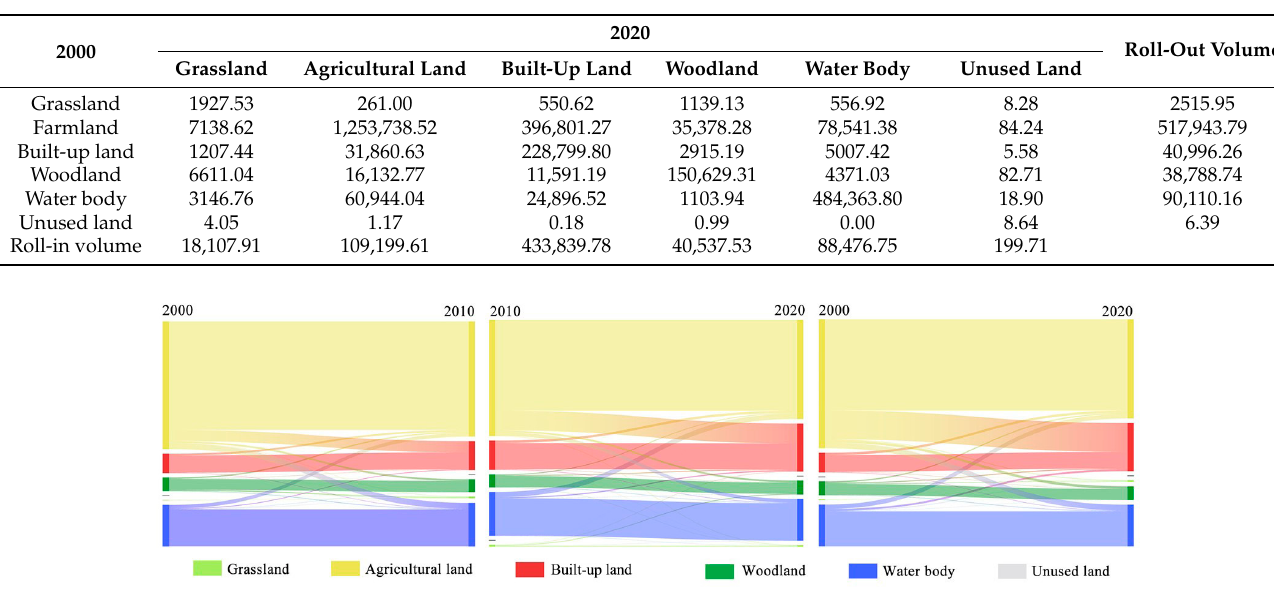
Table 3. Land-use conversion matrix from 2000 to 2020 (hm 2 ).